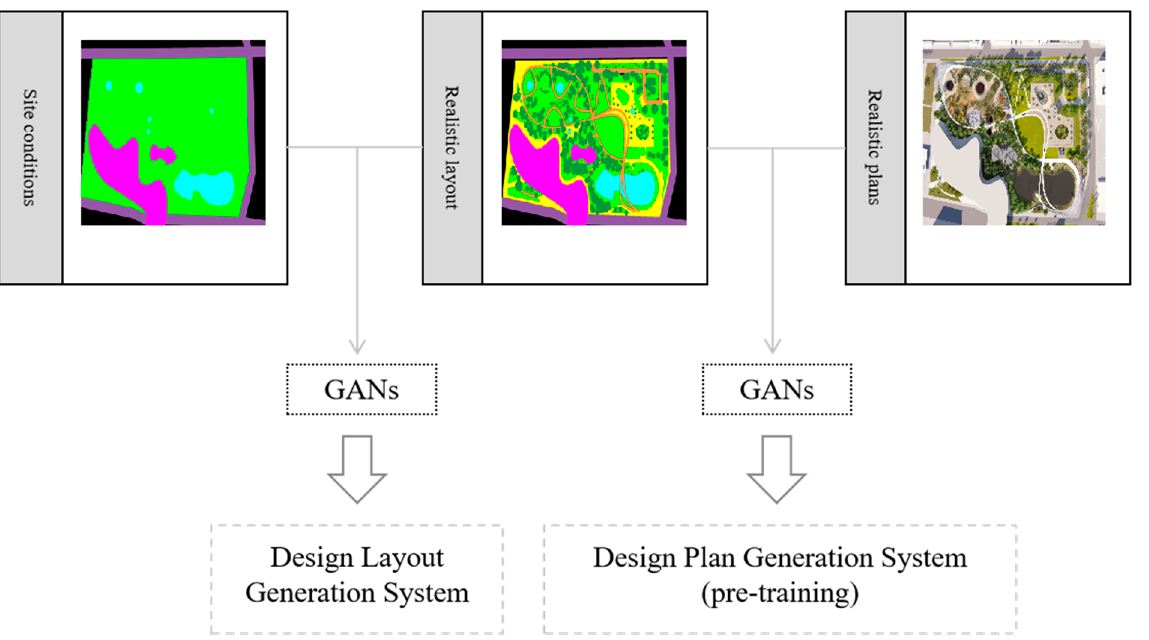
Figure 6. The overall workflow of pre-training. In the next term, the automatic plan optimization system and the semantic segmen- tation system were trained to realize data augmentation. This workflow is based on the pix2pix model [21], ROI technique, and 194 original datasets, as shown in Figure 7. The final enhanced dataset had 4047